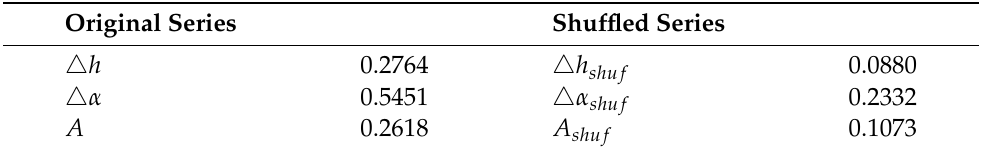
Table 2. Original series vs. shuffled series: Degree of multifractality, width of multifractal spectrum, and asymmetry